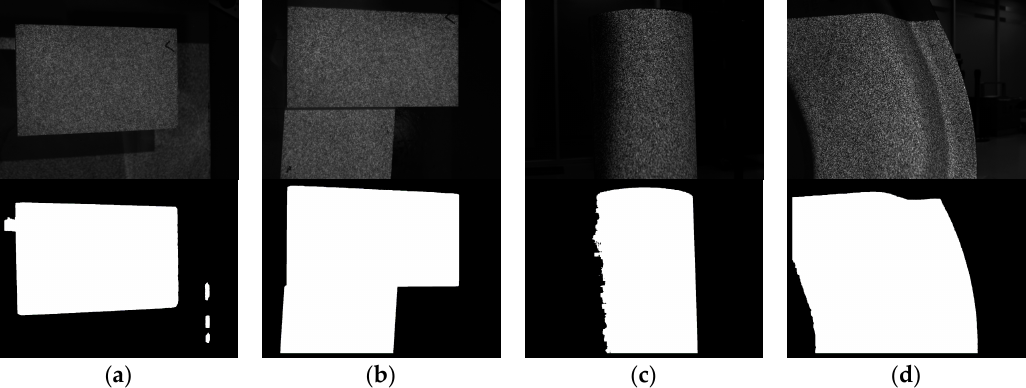
Figure 8. Experimental tests of proposed background segmentation method. ( a ) A plane surface; ( b ) a step surface; ( c ) a cylinder surface; and ( d ) a freeform surface.